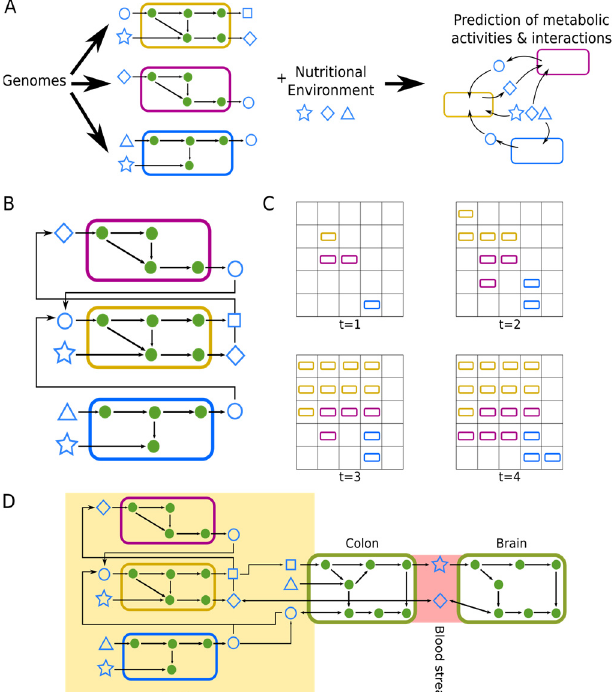
Figure 2. Microbial community modeling approaches. Circles correspond to metabolites, arrows to reactions. Shapes indicate exchanged metabolites. ( A ) General modeling approach. Genomes of bacterial species are translated into their corresponding metabolic network models. Additionally, information on the nutritional environment of the community is added (e.g., reported dietary uptake of a study participant). Subsequently, metabolic activities in individual bacterial species and metabolic exchanges between them can be predicted. ( B ) Community flux balance analysis. Bacterial metabolic networks are combined into a community level metabolic network and it is assumed that bacteria optimize their respective metabolic networks for most efficient community growth. ( C ) Individual- based modeling of microbial communities. Individual bacterial metabolic networks are simulated in a grid-like environment over time. Metabolic interactions occur as part of the secretion/consumption of metabolites by individual bacteria and diffusion of metabolites between grid cells. ( D ) Whole- body modeling. Metabolic networks of individual bacteria are joined with metabolic networks representing individual host tissues. Metabolic exchanges between bacteria and colon occur via a luminal compartment, metabolic exchanges between host tissues are mediated by the blood